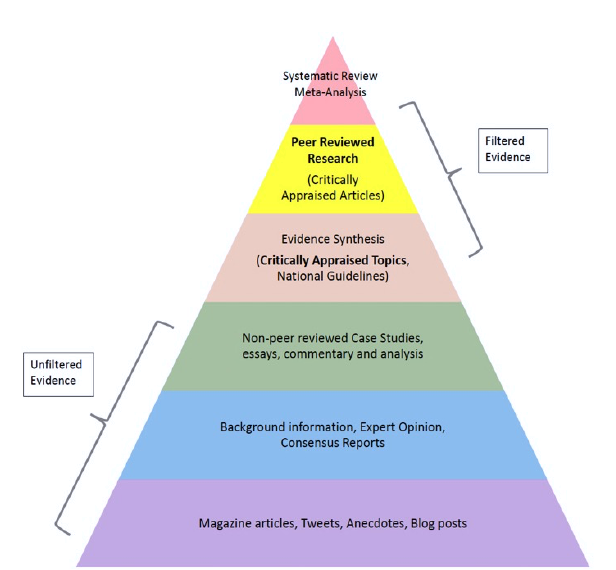
Figure 5. Filtered V Unfiltered